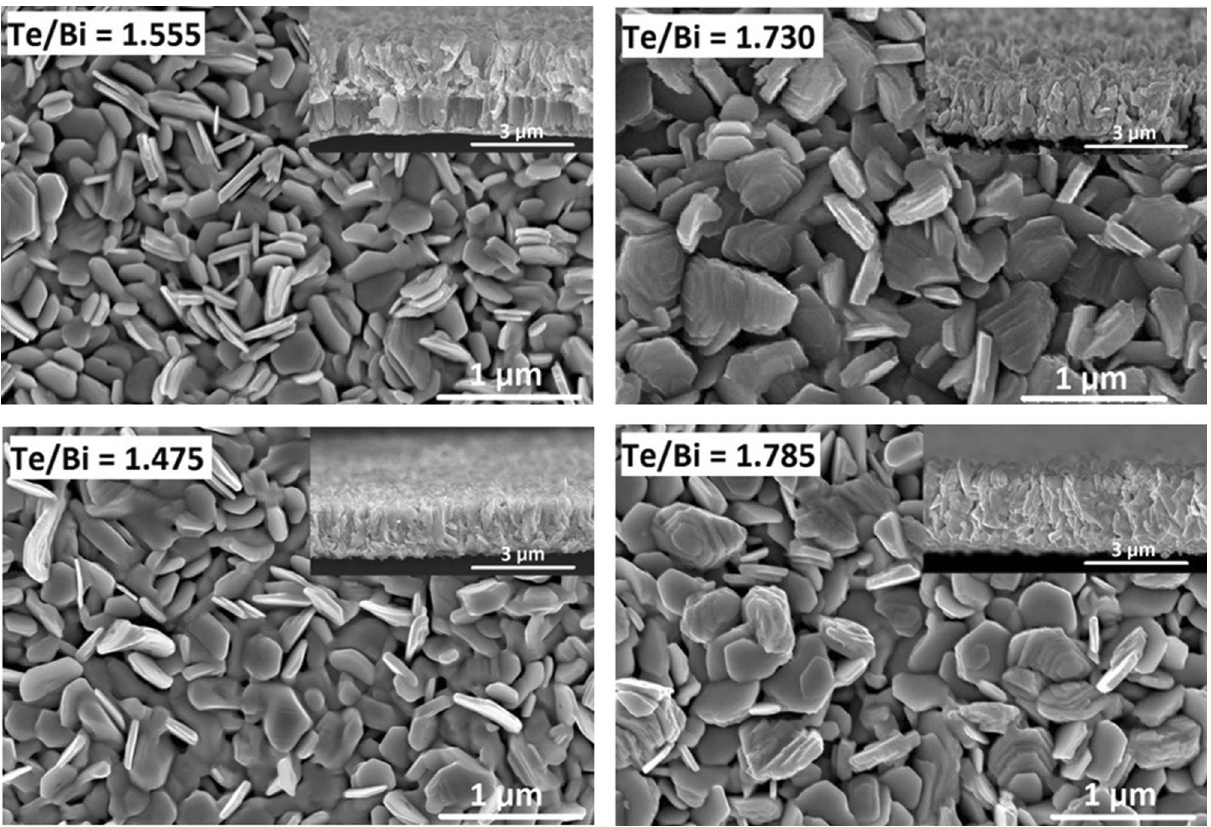
Figure 5. Scanning electron microscopy (SEM) images showing the surface and cross-sectional (inset) morphologies of the selected Bi–Te thin films fabricated at high substrate temperatures: top row with adhesion layer and bottom row without adhesion